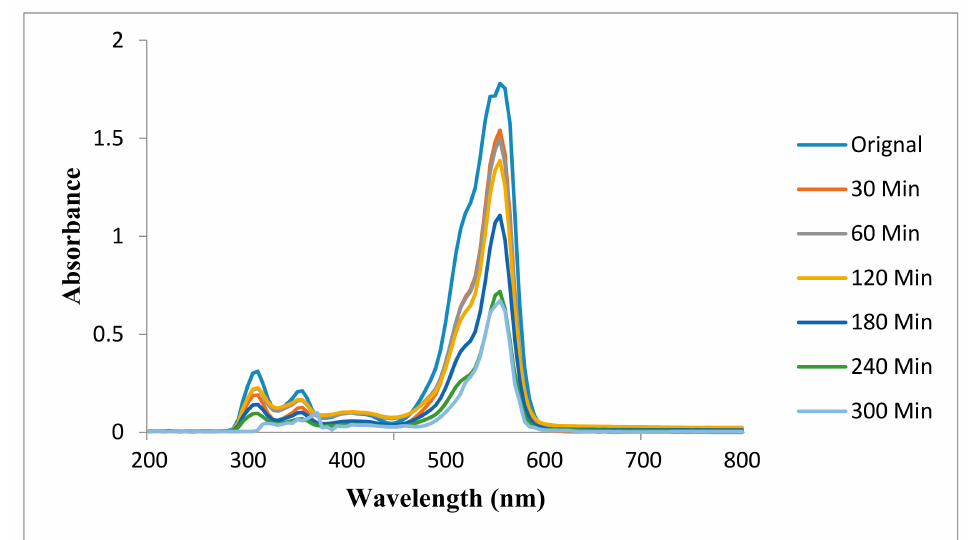
Figure 6. UV-visible spectra of RB degradation by Pd/ZrO 2